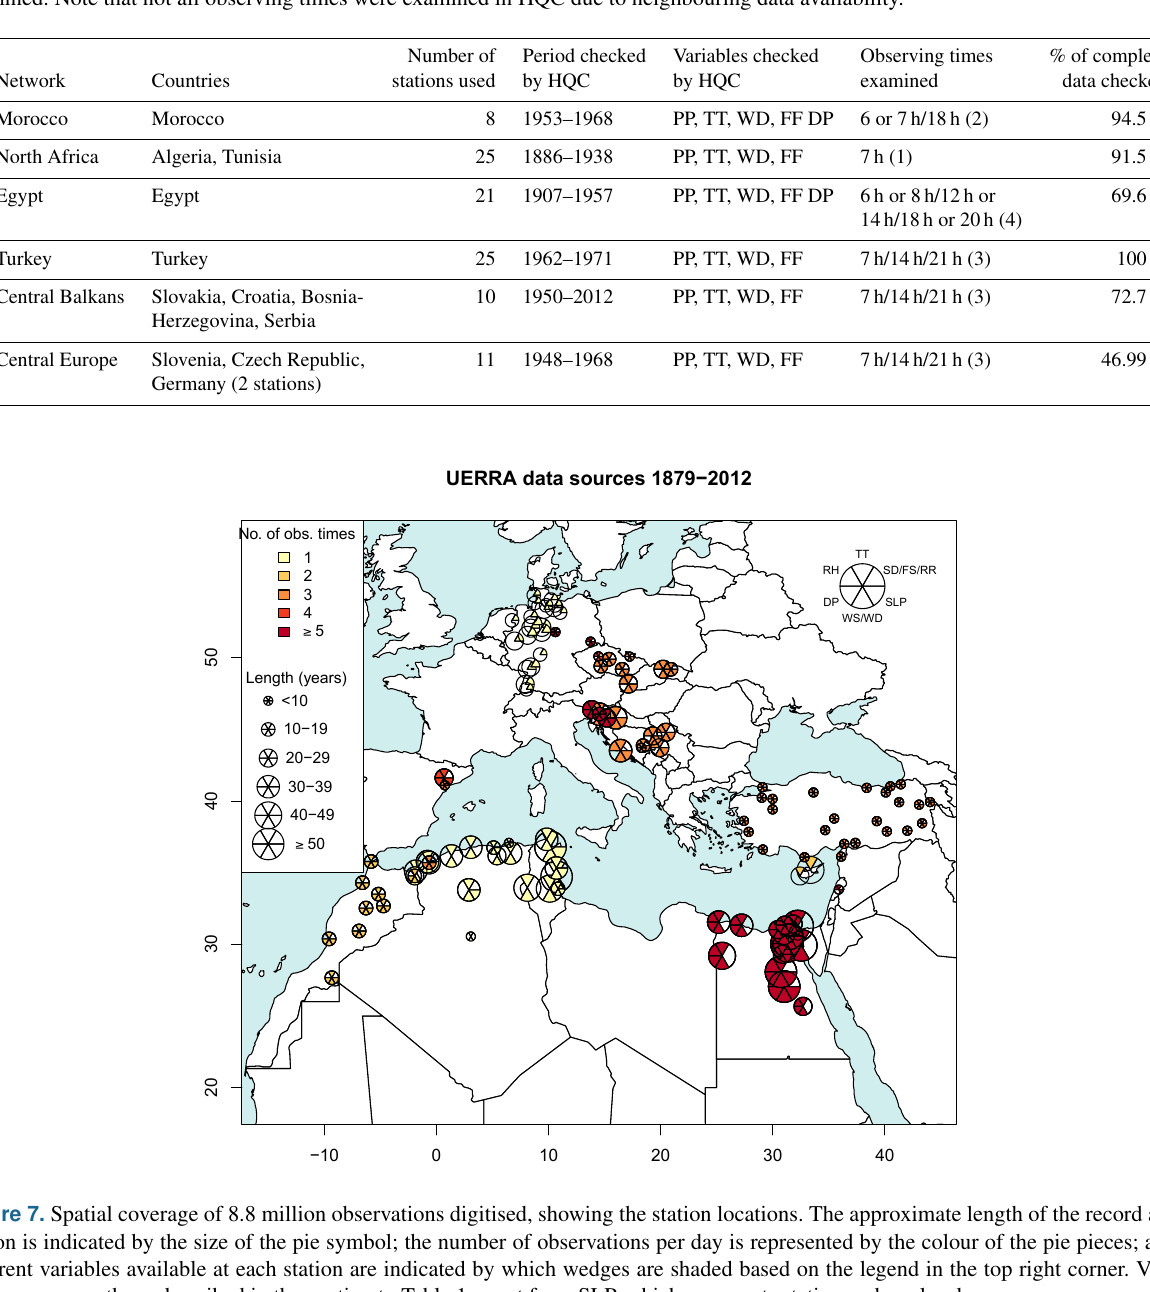
Table 5. The networks used in the spatial and automatic quality control analysis (HQC), including the period, variables and observing times examined. Note that not all observing times were examined in HQC due to neighbouring data availability.